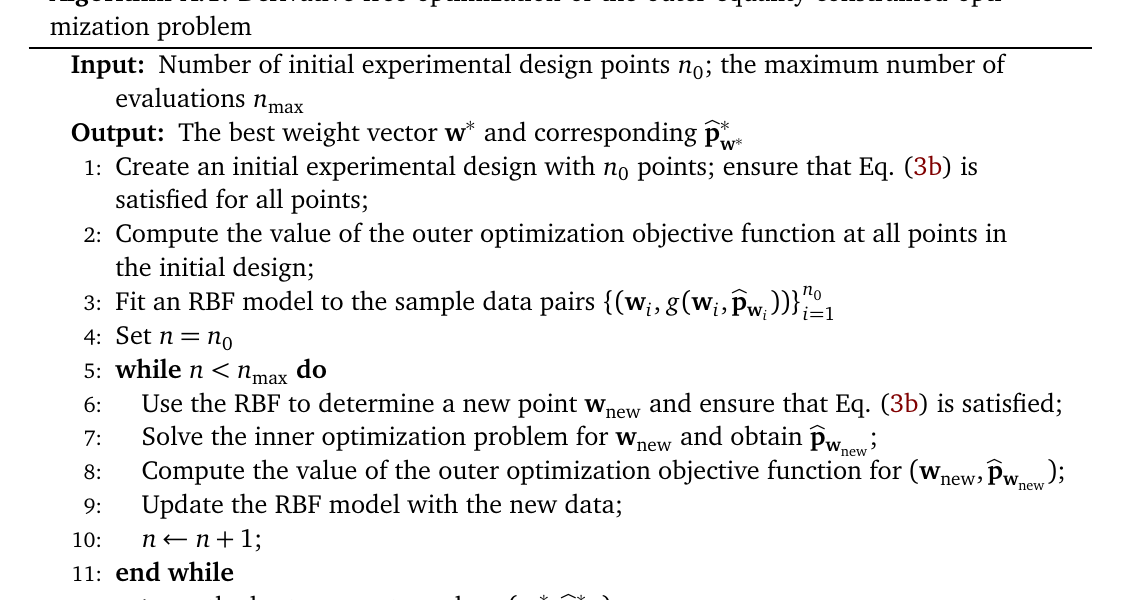
Algorithm A.1: Derivative-free optimization of the outer equality-constrained opti- mization